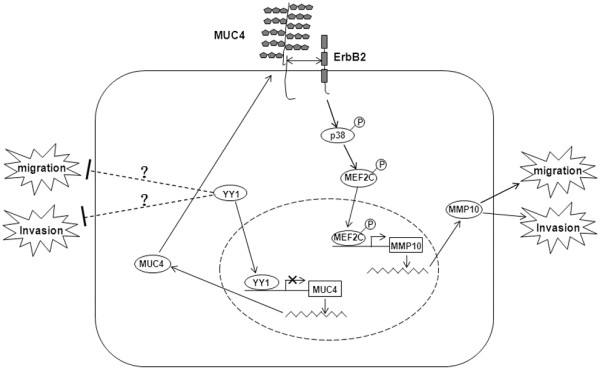
Schematic representation of the roles of YY1 on the migrating and invasive properties of BXPC-3 cells. YY1 suppresses invasion and metastasis of BXPC-3 cells by downregulating MMP10 in a MUC4/ErbB2/p38/MEF2C-dependent mechanism. “?” represents other undiscovered mechanisms that might be involved.